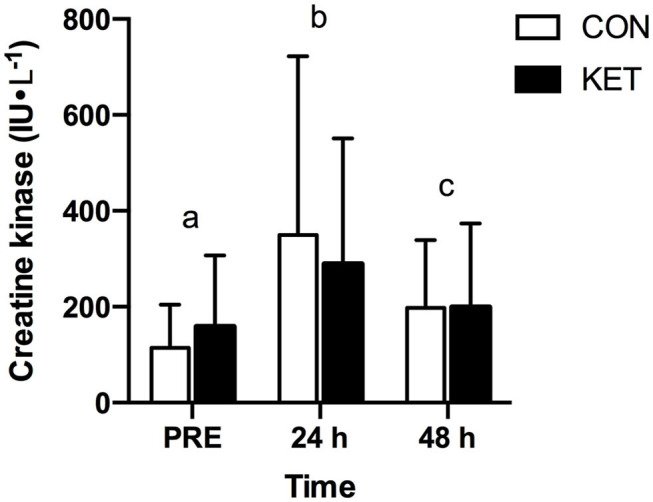
Serum creatine kinase concentration (IU·L−1) at baseline (PRE) prior to exercise, and 24 h and 48 h after exercise. Values represent means ± SD. Times without a common letter differ. Data were analyzed with a two-factor repeated measures (within subject factor: time; between-subject factor: group) ANOVA. Bonferroni-corrected post-hoc comparisons were performed following a significant main effect for time or group × time interaction. Time effect: P < 0.001; group effect: P = 0.918; group × time interaction: P = 0.313. CON, carbohydrate control group; KET, ketone monoester group.